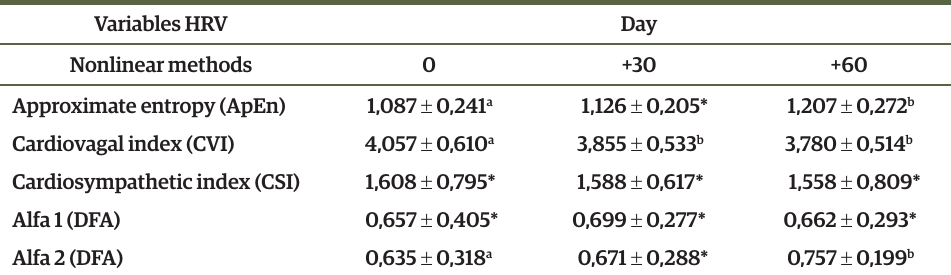
Table 4. Average and Standard Deviation of Heart Rate Variability measurements, nonlinear animal methods before (day 0) and after rhinoplasty procedure (days +30 and +60).